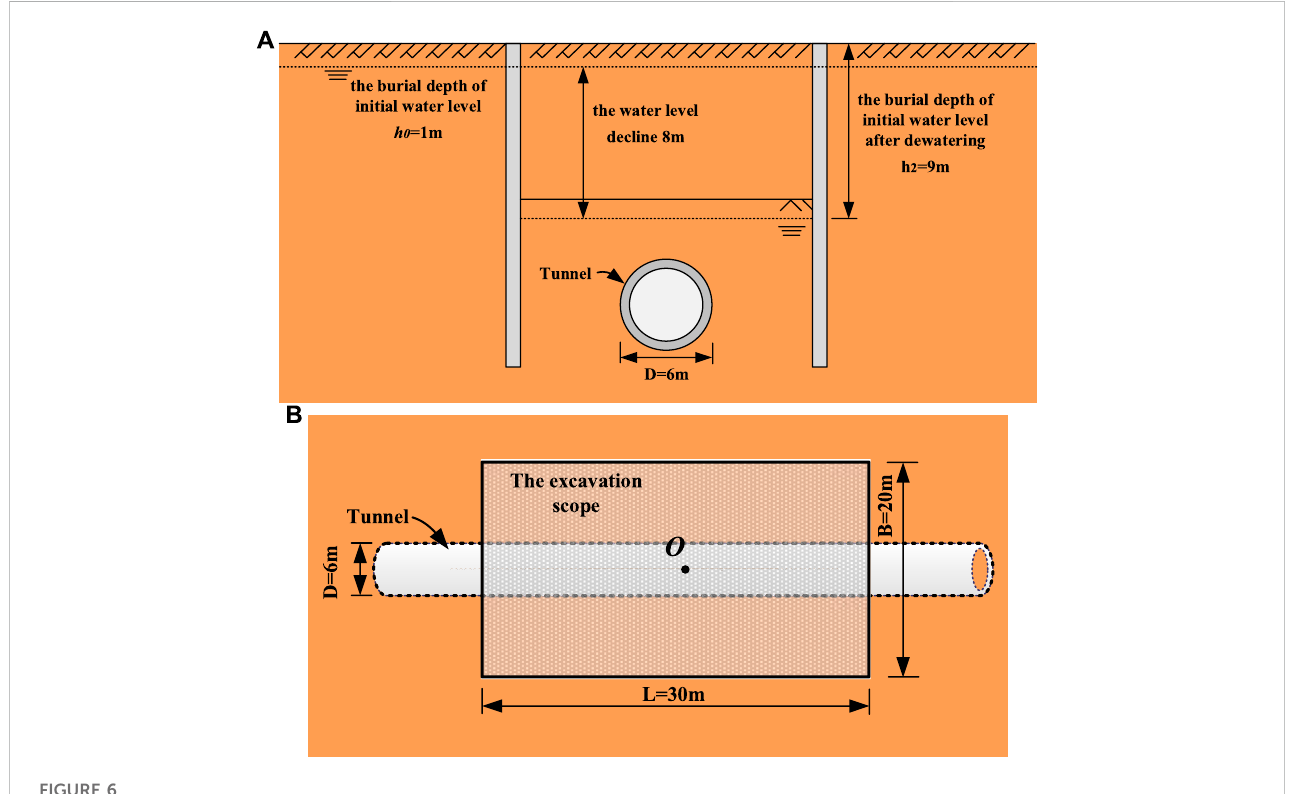
FIGURE 6 Engineering schematics: (A) sectional view; (B) plan view.